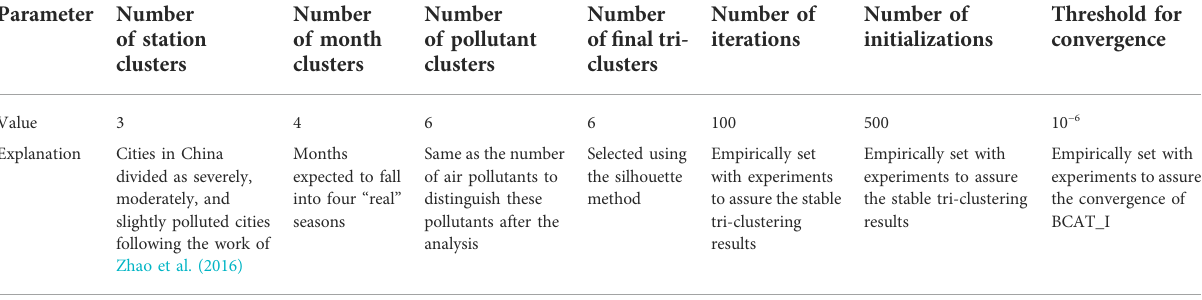
TABLE 1 Parameters for the tri-clustering analysis of the air pollutant dataset.